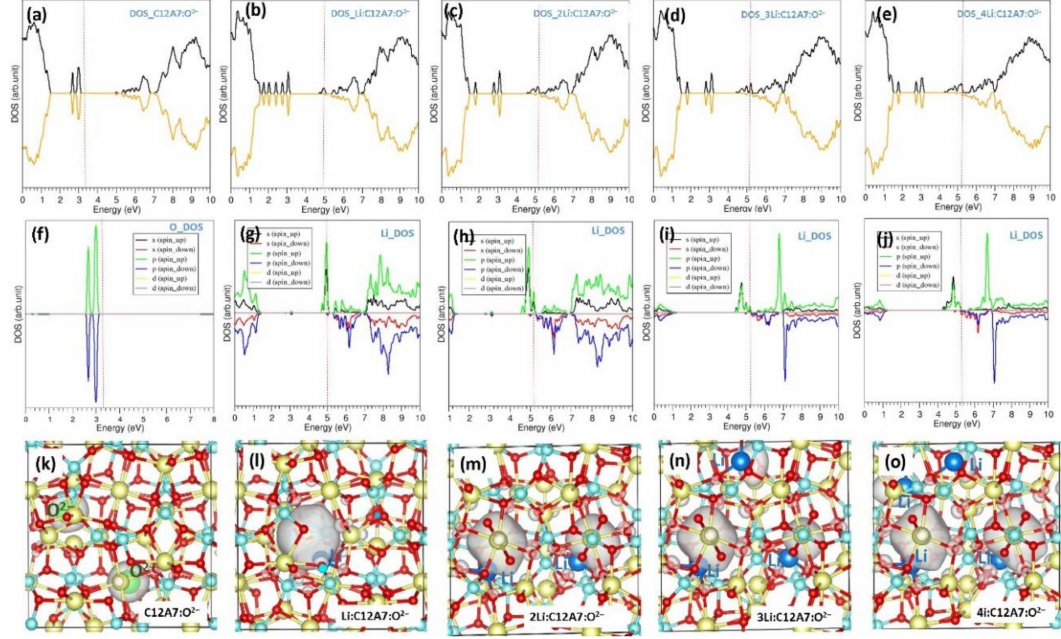
Figure 3. ( a – e ) Total densities of states (DOSs) of C12A7:O 2 − , Li.C12A7:O 2 − , 2Li.C12A7:O 2 − , 3Li.C12A7:O 2 − and 4Li.C12A7:O 2 − . ( f – j ) Corresponding atomic DOSs and ( k – o )